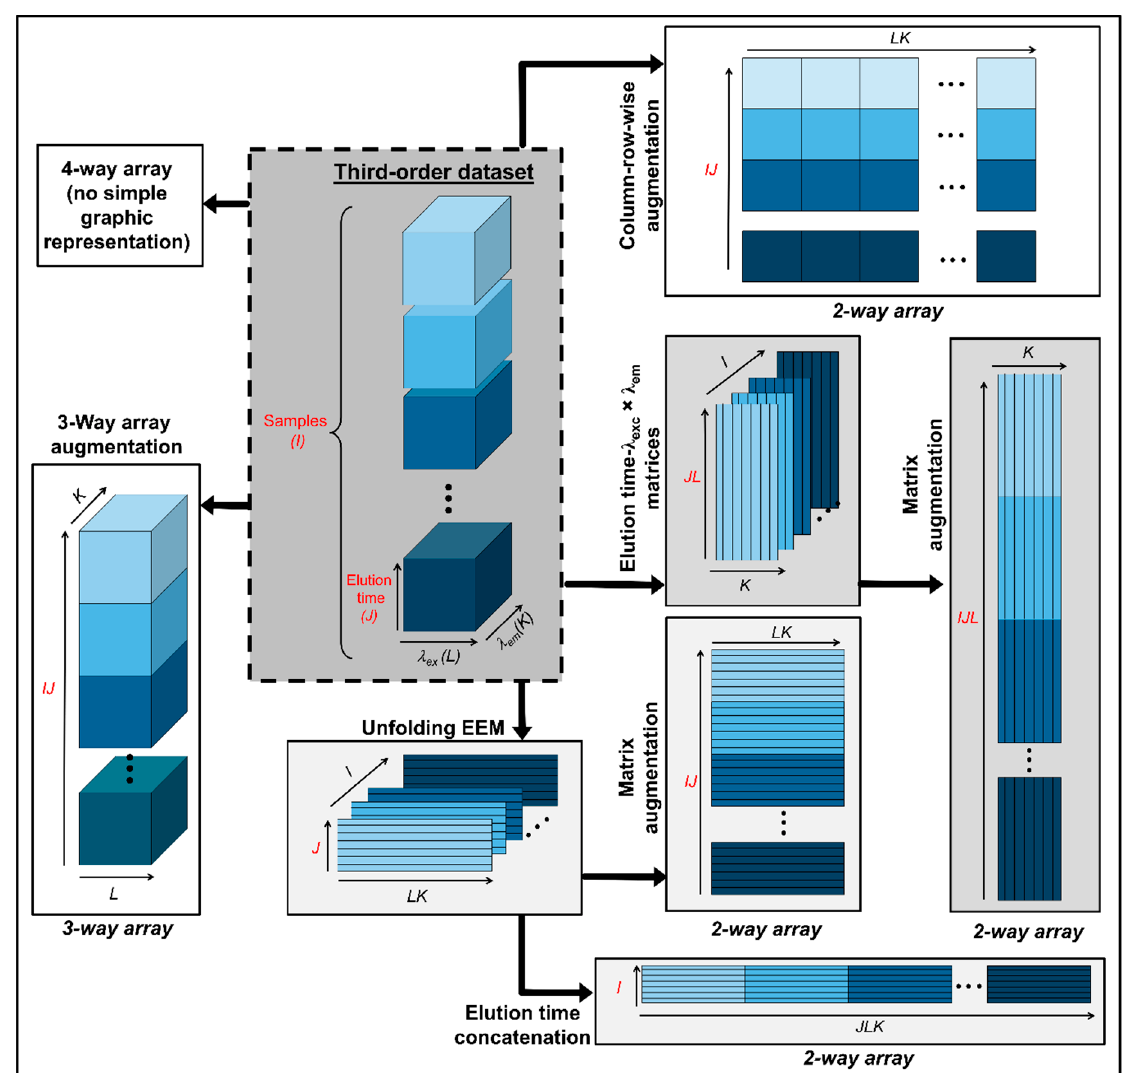
Figure 2. Possible data arrays that can be built with third ‐ order data prior to chemometric